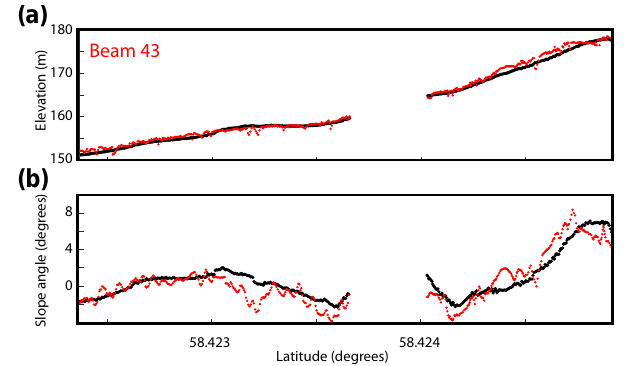
Figure 10. MABEL and DEM surfaces and slopes for a small stretch (see box in Fig. 8b) on the Lower Taku Glacier. (a) MABEL (red) and extracted DEM (black) elevations in meters, for beam 43, migrated based on GPS data and corrected for an 8m range bias. (b) MABEL (red) and DEM (black) across-track slope angle in de- grees, using beams 43 and